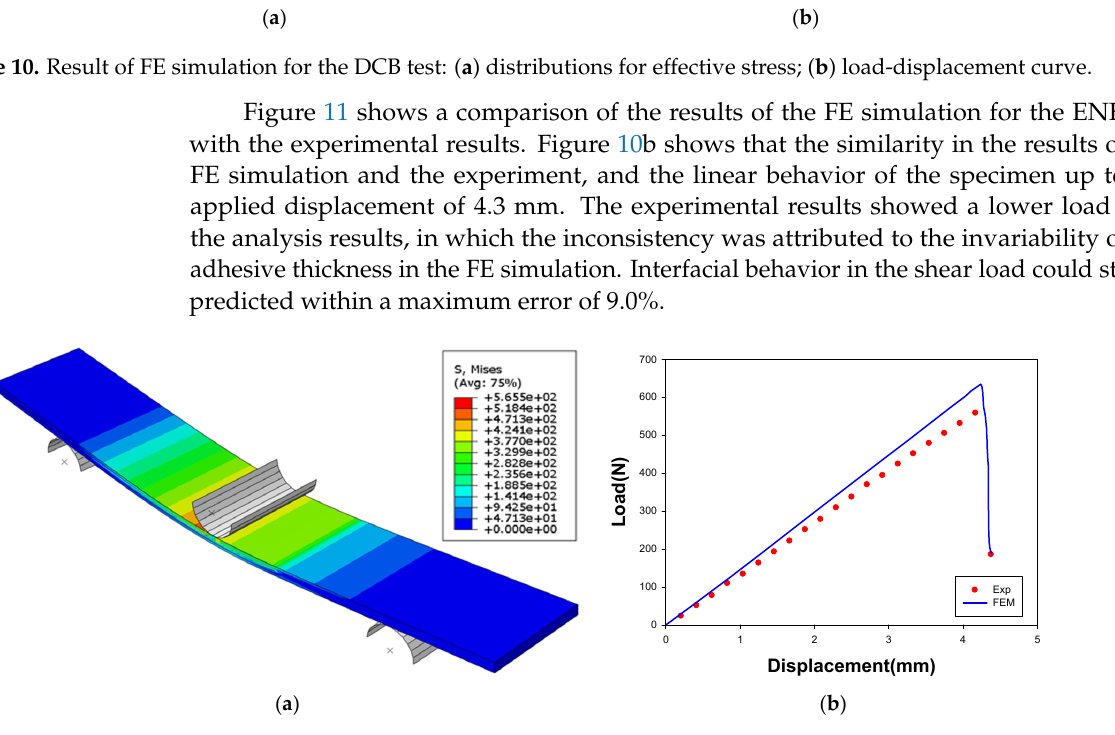
Figure 11. Result of FE simulation for the ENF test: ( a ) Distributions for effective stress; ( b ) Load-displacement curve.